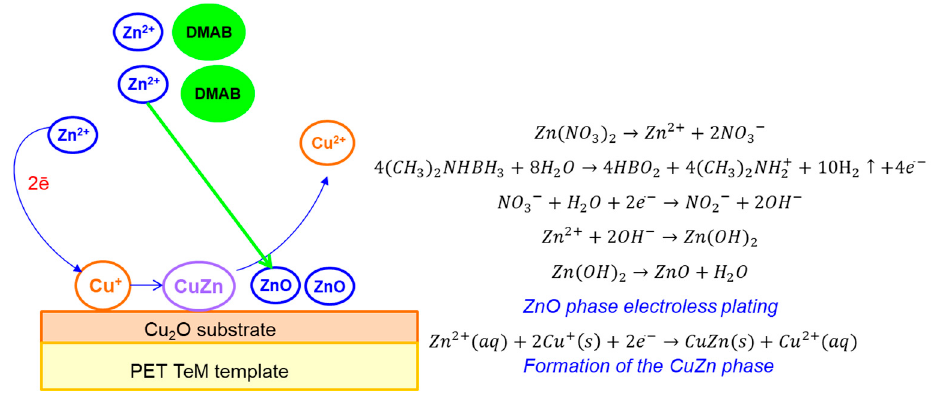
Figure 4. A schematic illustration of the synthesis of the Cu 2 O/ZnO@PET composite membrane based on the galvanic replacement reaction.